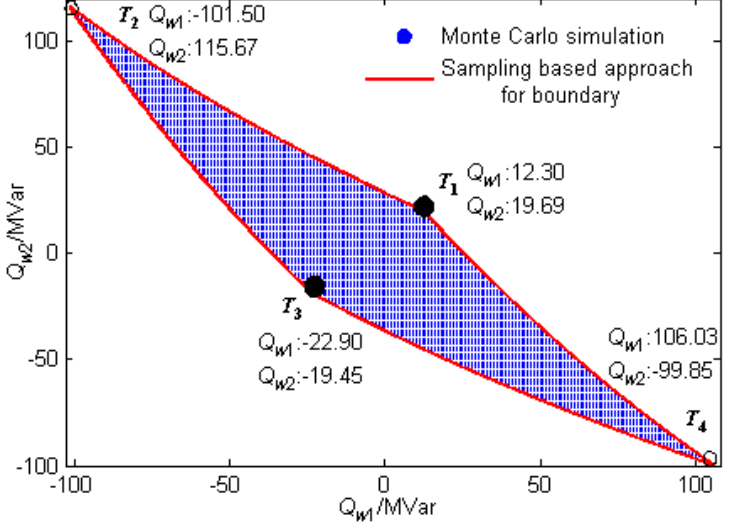
Figure 7. Initial voltage security region ( Ω sampling-based